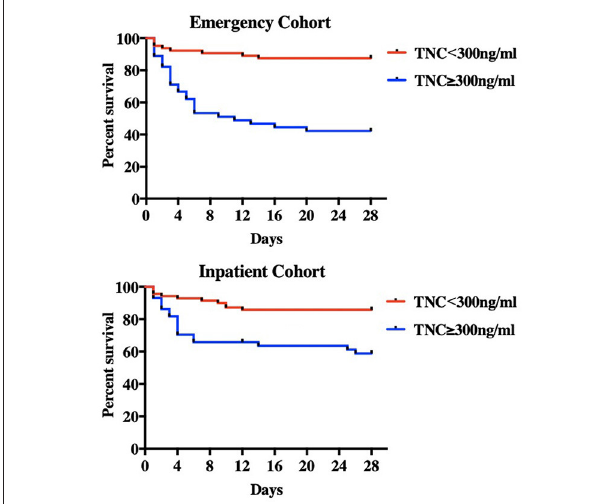
FIGURE 2 | Kaplan-Meier survival curve. By reference to the optimal cut-off value, the patients were divided into serum TNC ≥ 300ng/ml and TNC < 300ng/ml groups. Compared with lower TNC group, the higher TNC group had a significantly lower survival rate in both emergency (derivation) cohort (log rank test, p < 0.0001) and inpatient (validation) cohort (log rank test, p =